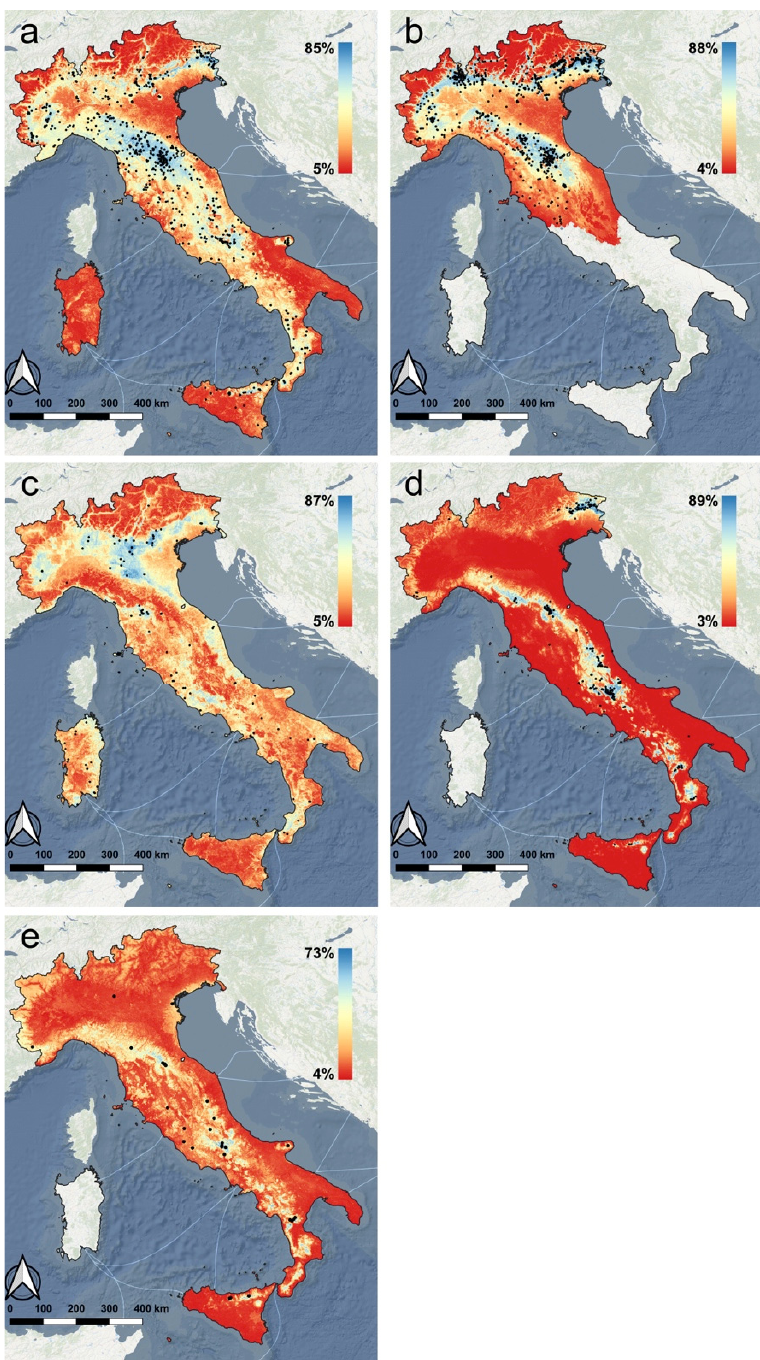
Figure 1. Maps of the suitable habitat for each TU, where the colour scale represents the habitat suitability (HS) from minimum (red) to optimal HS (blue). Black points represent the distribution of the big five occurrence data used in the SMD framework. Reports from the Life MIPP and InNat citizen science projects were selected excluding duplicate occurrences and doubletons within the same ~1 km 2 cell. In ( a ), the HS map of Morimus asper asper / funereus ; in ( b ), Lucanus cervus ; in ( c ), Cerambyx cerdo ; in ( d ), Rosalia alpina ; in ( e ), Osmoderma spp. The L. cervus HS map was clipped in central Italy according to its known occurrence data and considering that only L. tetraodon is present in southern